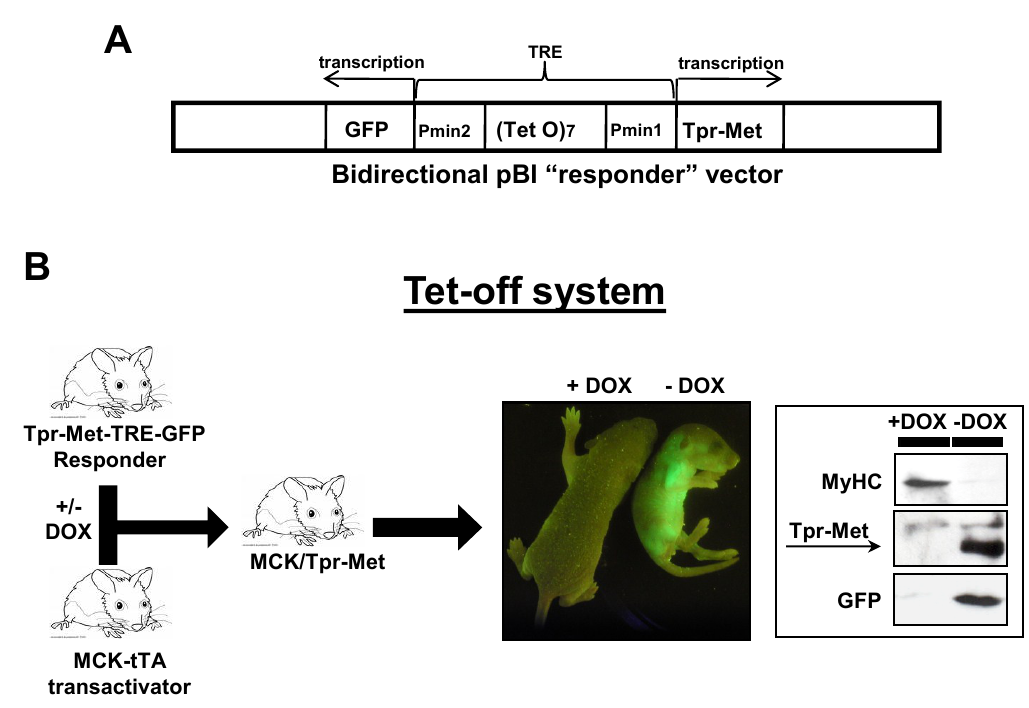
Figure 1. Inducible Tpr–Met–TRE–GFP/MCK–tTA mouse model. ( A ) Schematic representation of Tpr–Met–TRE–GFP transgene in the bidirectional pBI “responder” vector; ( B ) breeding strategy to generate bitransgenic mice (MCK/Tpr–Met), conceived and